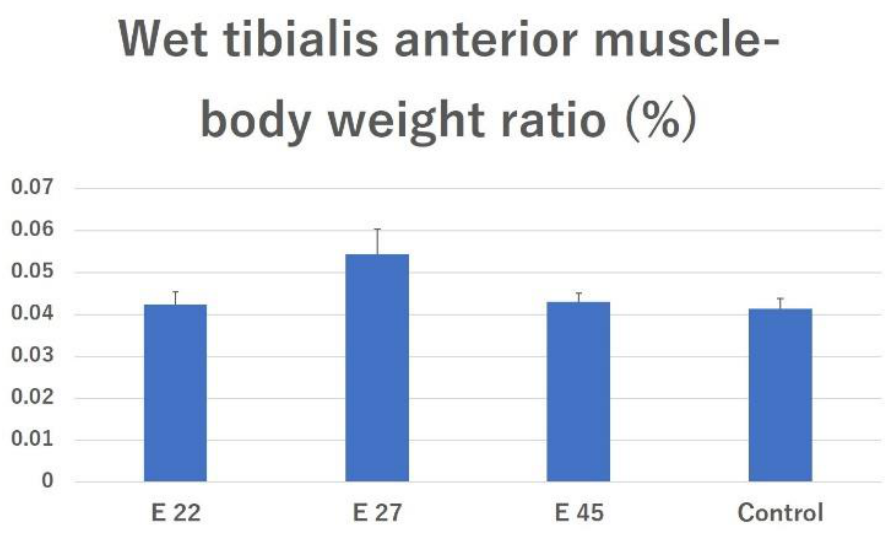
Figure 3. Effects of preventing muscle atrophy. Wet tibialis anterior muscle-body weight ratios of different groups were calculated and compared. The data are presented as mean ± SE.